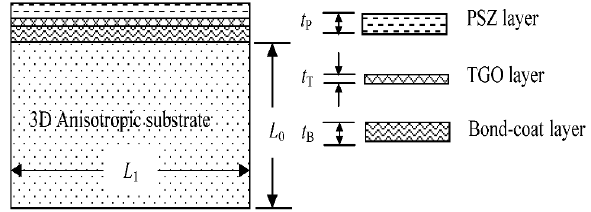
Figure 1. Front view of a typical 3D TBC system.